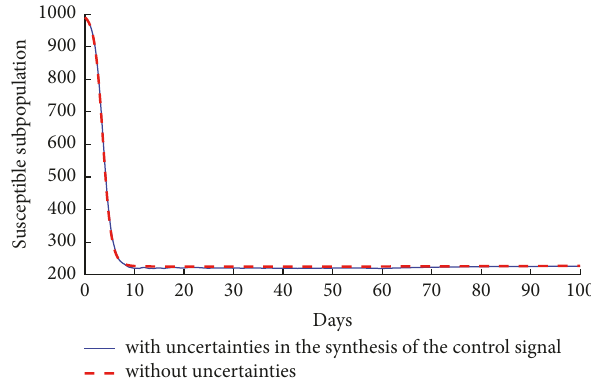
with uncertainties in the synthesis of the control signal without uncertainties Figure 21: Susceptible subpopulations with (i) the vaccination strategy designed if there are uncertainties in the measures of the subpopulations and (ii) the basic vaccination strategy without uncertainties.